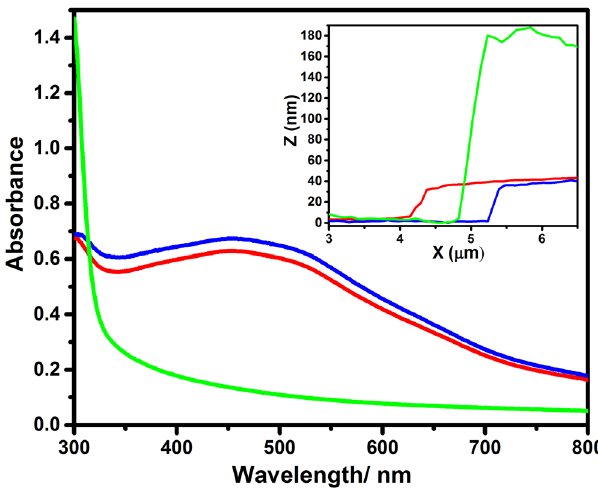
Figure 3. Electronic absorption spectra of a B- γ -CsSnI 3 + 10 mol% SnCl 2 film on: glass (red); a bilayer of B- γ - CsSnI (blue); a CuSCN film (green). A statistical analysis of the step edges in scored films is given in Supplementary Information Figure